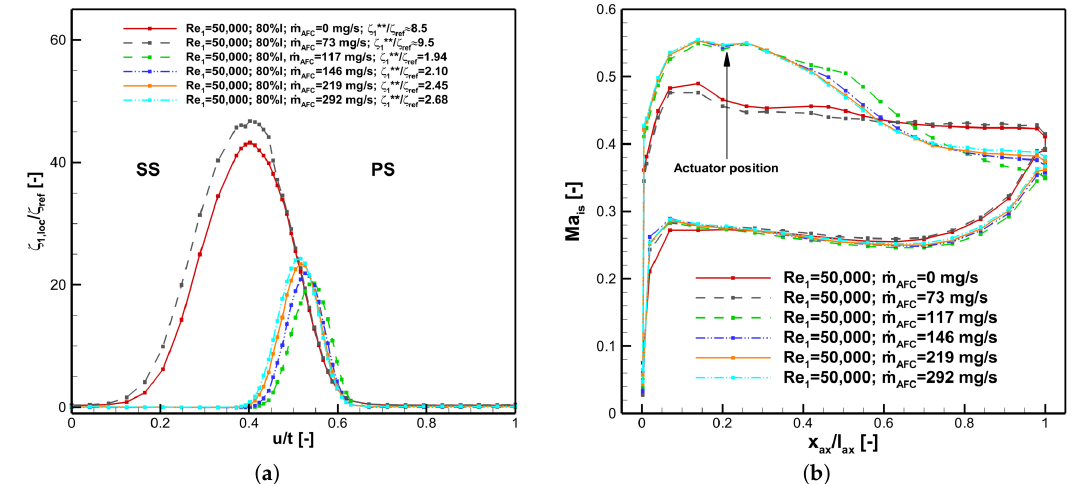
Figure 4. ( a ) Local total pressure loss and ( b ) isentropic Mach number distribution for different mass flow rates at Re 1